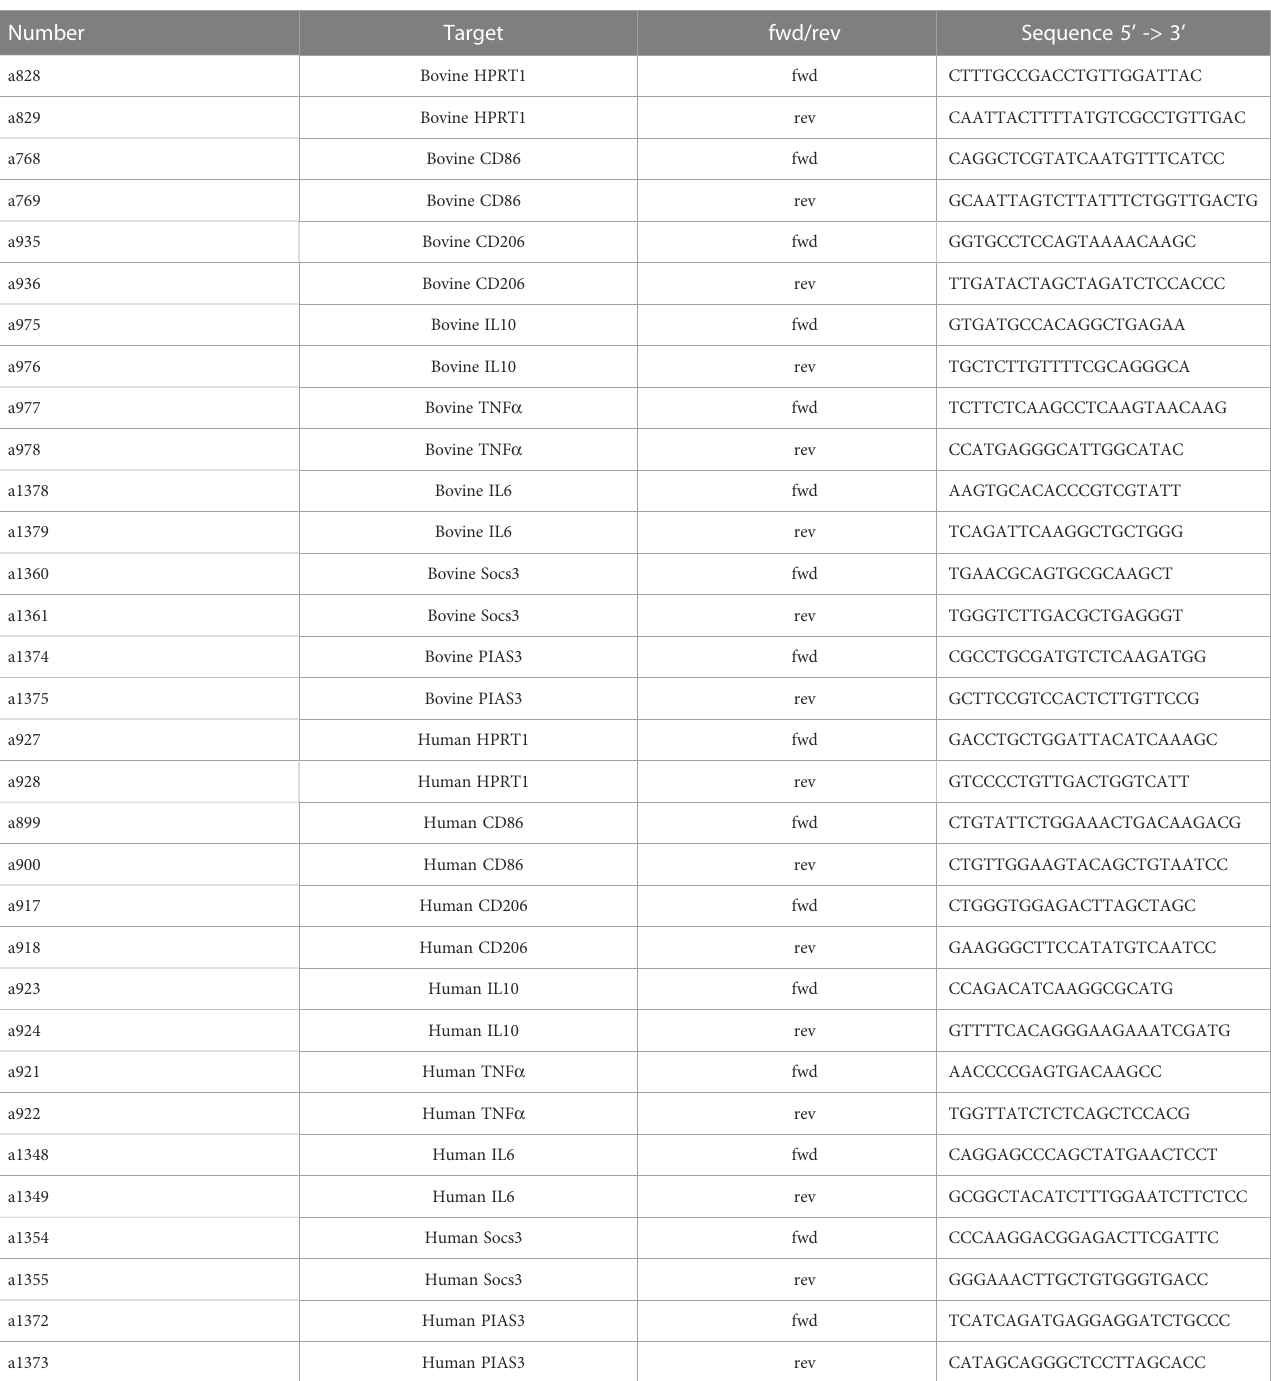
TABLE 1 Primers